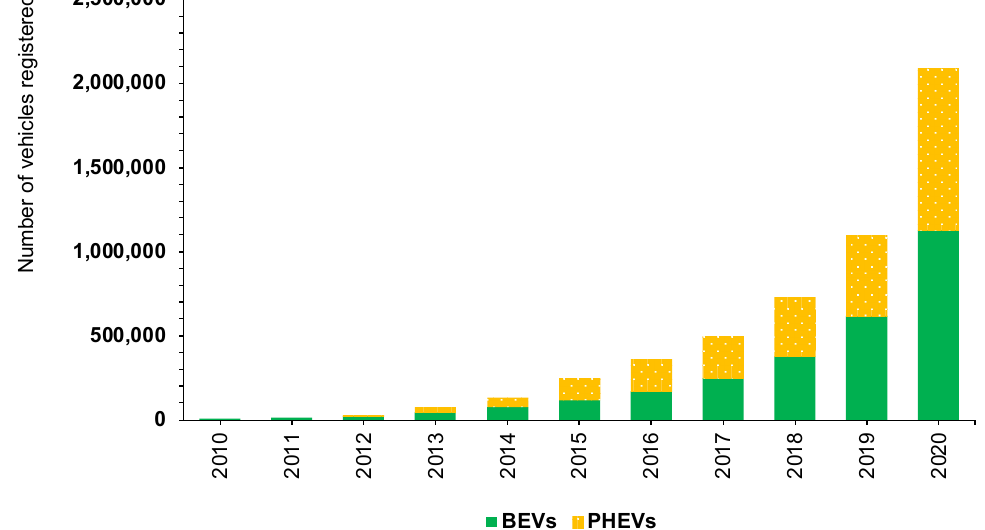
Figure 3. Total number of BEVs and PHEVs registered in 27 EU countries + Norway and the United Kingdom between 2010–2020. The authors created this figure with data from the European Alternative Fuels Observatory (EAFO) [19].